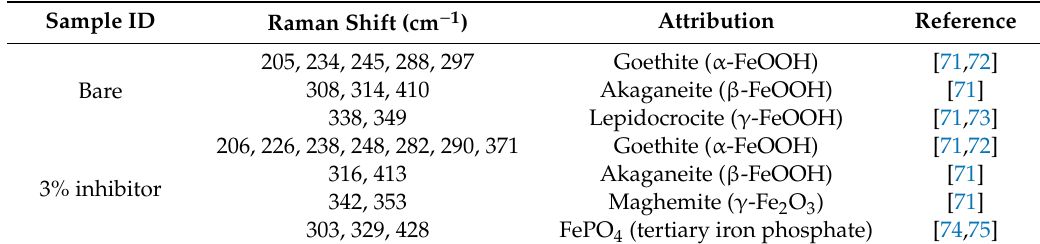
Table 5. Attribution of Raman peaks formed on steel rebar surface after 120 h exposure in bare and 3% inhibitor-added SCP + 3.5 wt% NaCl